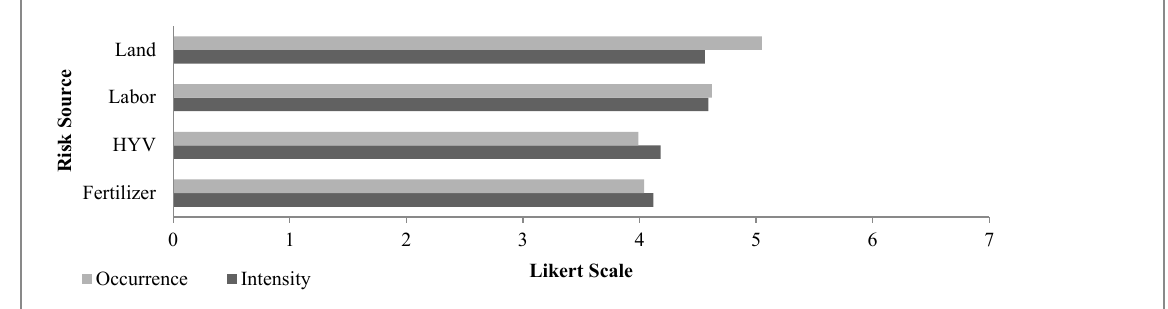
Figure 3. Input availability risk perception .